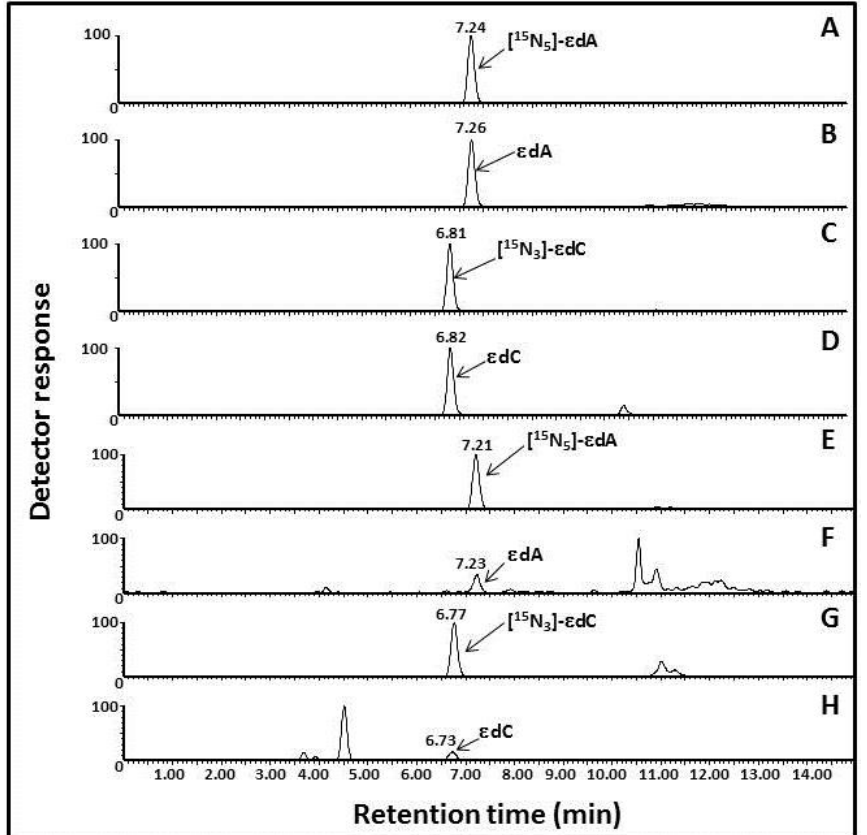
Figure 3. Typical UPLC-MS-MS chromatography profiles of 1, N 6 -etheno-2’-deoxyadenosine (  dA) and 3, N 4 -etheno-2’-deoxycytidine (  dC) detected in human urine. A, [ 15 N 5 ]  dA as I.S.; B,  dA standard; C, [ 15 N 3 ]  dC as I.S.; D,  dC standard; E, [ 15 N 5 ]  dA as I.S. in 1.0 mL of human urine; F,  dA detected in 1.0 mL of human urine; G, [ 15 N 3 ]  dC as I.S. in 1.0 mL of human urine; H,  dC detected in 1.0 mL of human